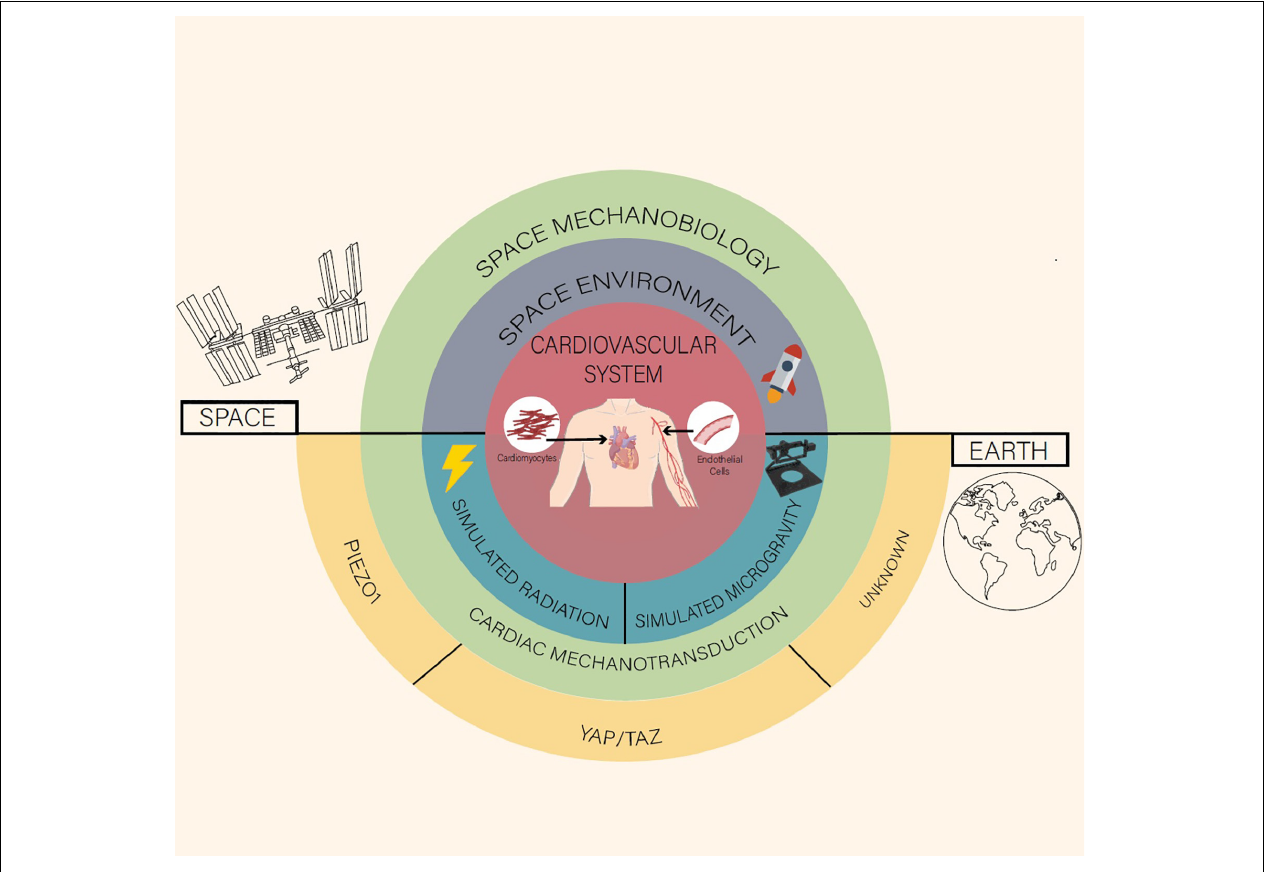
FIGURE 1 | A space mechanobiology approach toward cardiovascular function and